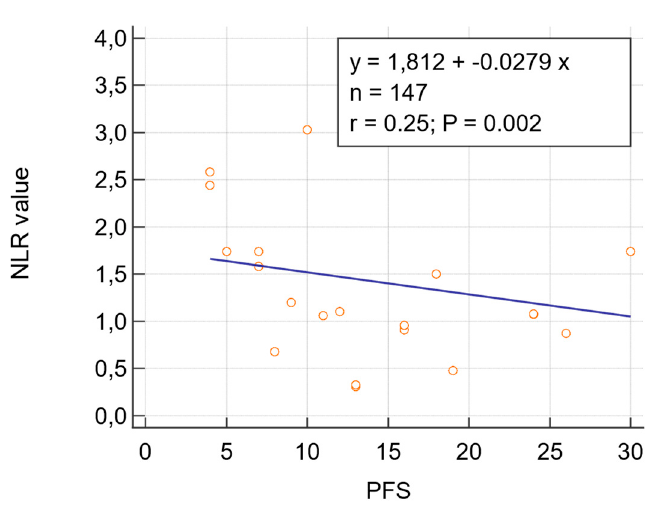
Figure 2. Regression analysis between NLR after three NACT cycles and PFS.